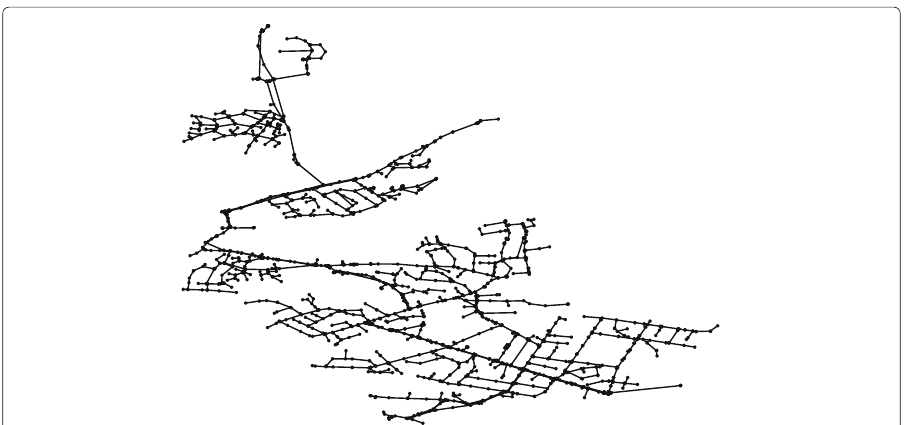
Fig. 6 All mains model of BWFL. The all mains model of BWFL represents the network before the reduction step is